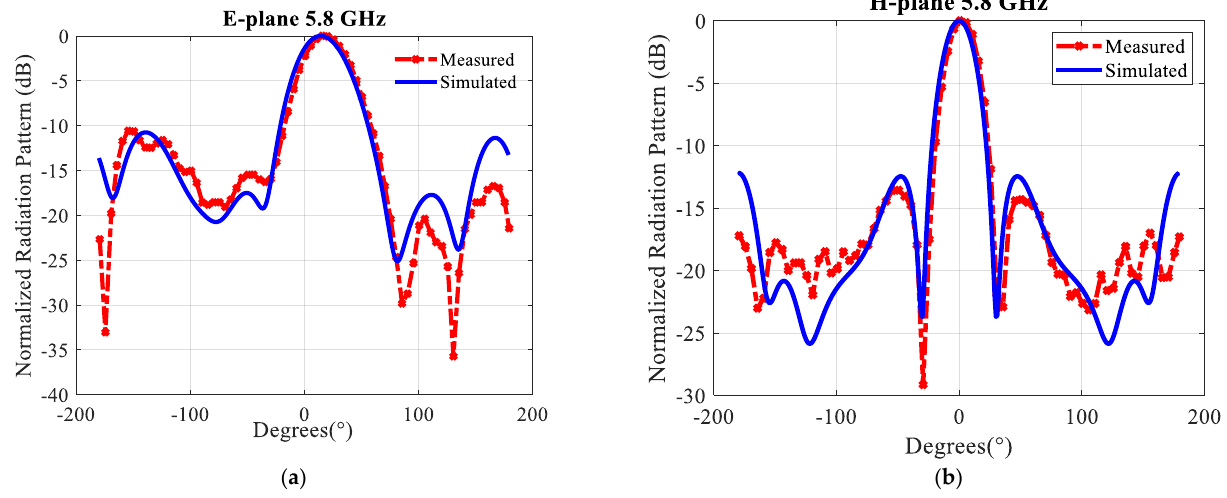
Figure 17. ( a ) Prototype of the 2 × 4 array, ( b ) Simulated and measured reflection coefficients (|S11|) of the integrated structure including the feeding network.